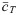
A: Calcium traces obtained with the full subcellular model and three different values of the average calcium concentration, c¯T. B: Line-scans at different values of the load. Increasing the load, the system undergoes a transition from a low cytosolic calcium state (at c¯T=47μM), where RyRs remain in the closed state, to spontaneous oscillations, giving rise to calcium waves (c¯T=65μM). Finally, at high calcium loads (c¯T=73μM) oscillations give rise to a high cytosolic calcium state, where the RyRs remain open, resulting in SR calcium depletion.